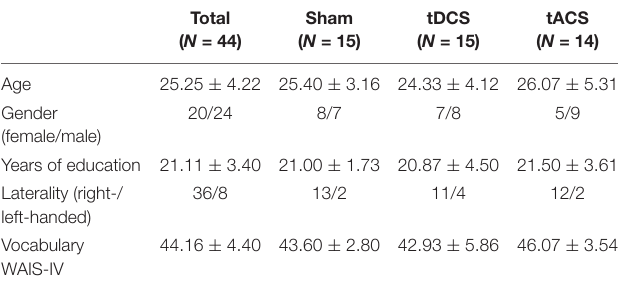
TABLE 2 | Demographics and neuropsychological data.